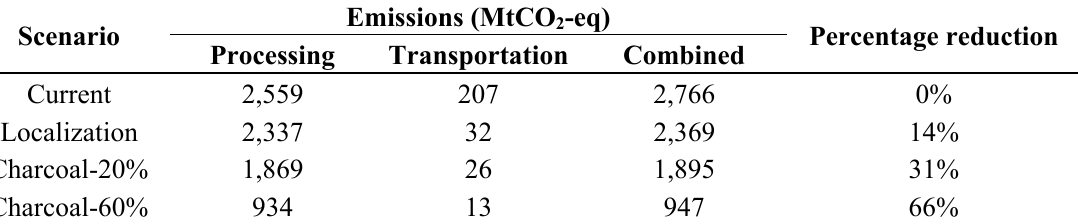
Table 11. Summary of iron and steel industry